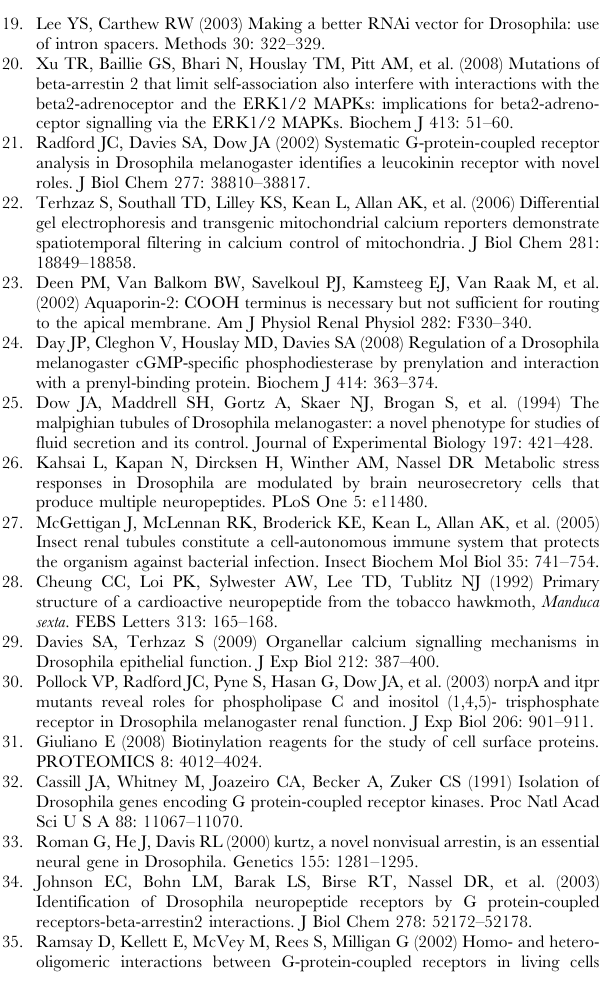
Table S1 Affinities of the Drosophila capa